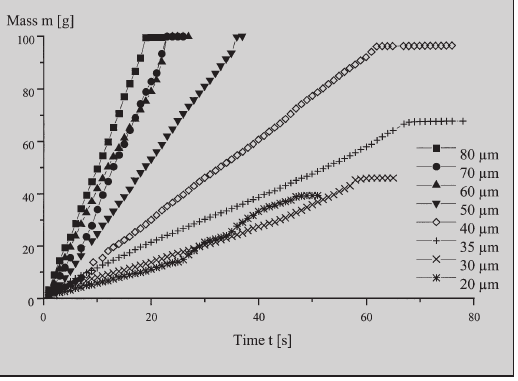
Figure 10 (left): Outflowing mass as a function of time and different particle sizes. Figure 11: Torque and outflowing mass as a function of time.